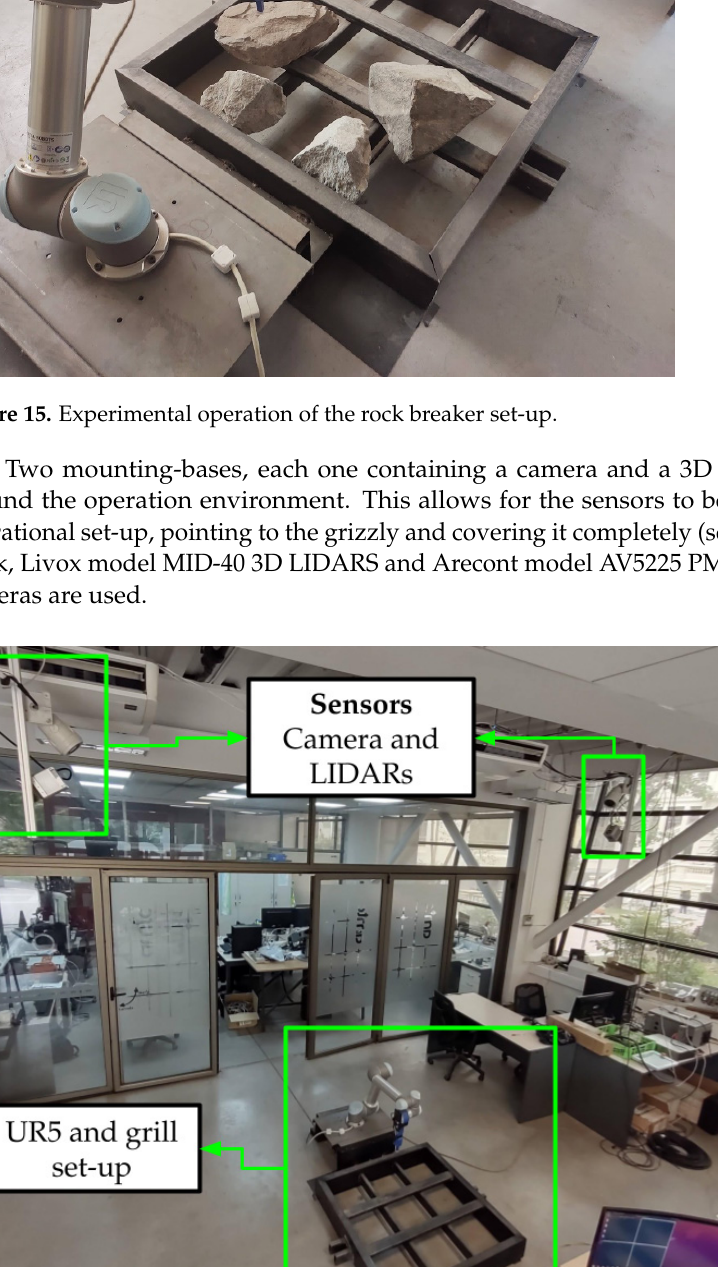
Figure 14. Articulated model of the adapted UR5. The green joints (J1, J2, J3, and J4) correspond to the articulated joints. The red (J5 and J6) correspond to the fixed joint of the kinematic model.